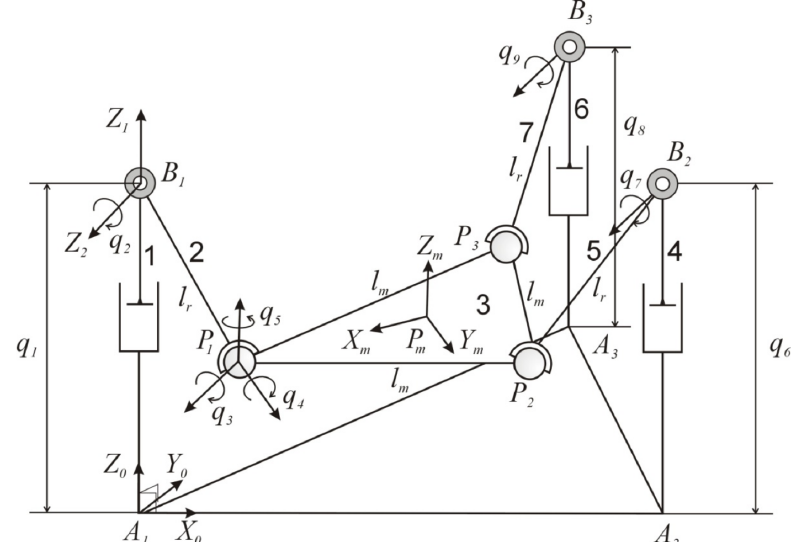
Figure 2. Kinematic diagram of the three-PRS, type of joints, and generalized